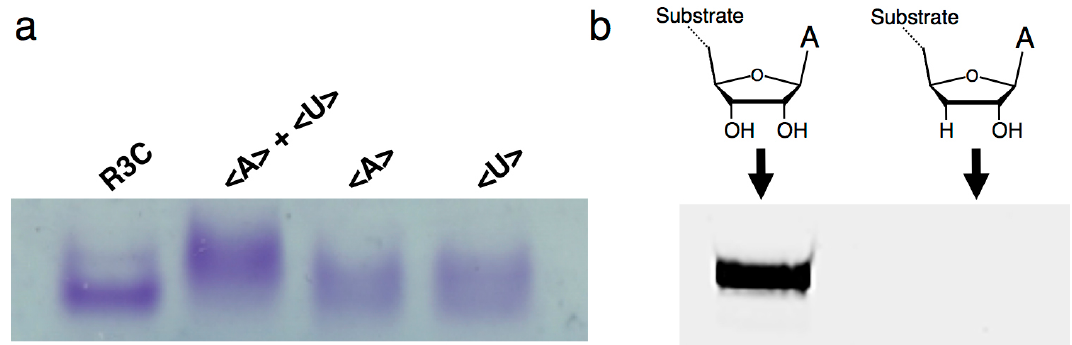
Figure 5. ( a ) Electrophoretic mobility shift assay of the (from left to right) full-length R3C ligase ribozyme, mixture of <A> and <U>, <A> alone, and <U> alone. The nucleotides were separated via native 8% polyacrylamide gel electrophoresis. The gel was stained with 0.04% toluidine blue. ( b ) Analysis of the ligation product by the R3C ribozyme using an RNA substrate possessing 3 ′ -deoxyadenosine at the 3 ′ -terminal (5 ′ -CGACUCACUAUA(3 ′ -deoxy)-3 ′ ). The volume of the reaction mixture was 15 μ L and the incubation was performed at 23 °C for 18.5 h. The gel was visualized on Typhoon FLA 7000 (GE Healthcare Japan, Tokyo, Japan).